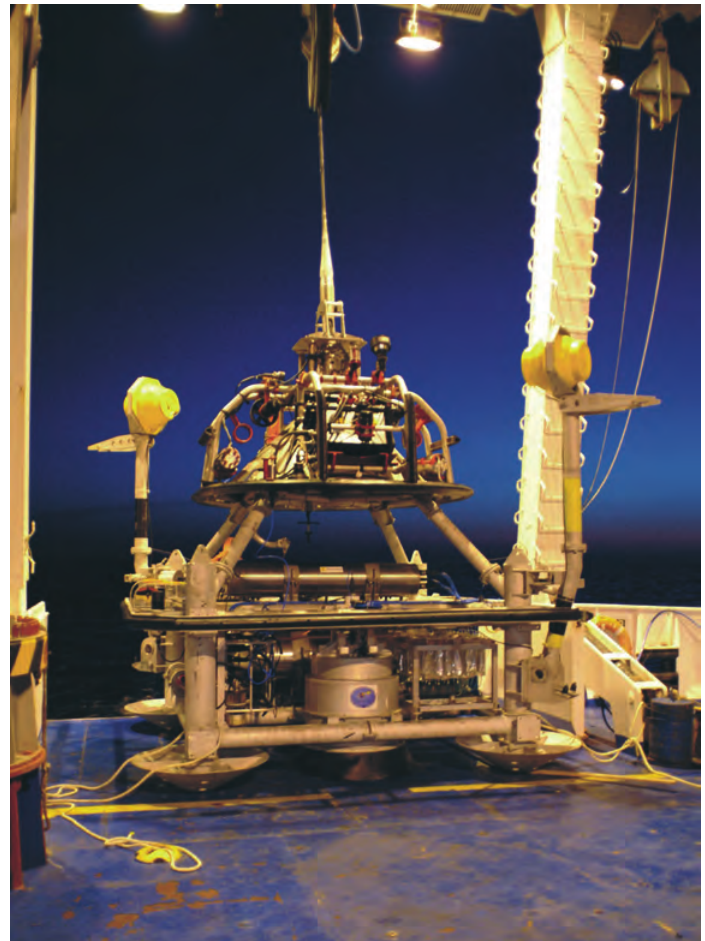
Fig. 1. GEOSTAR seafloor observatory: Bottom Station with MODUS vehicle on the